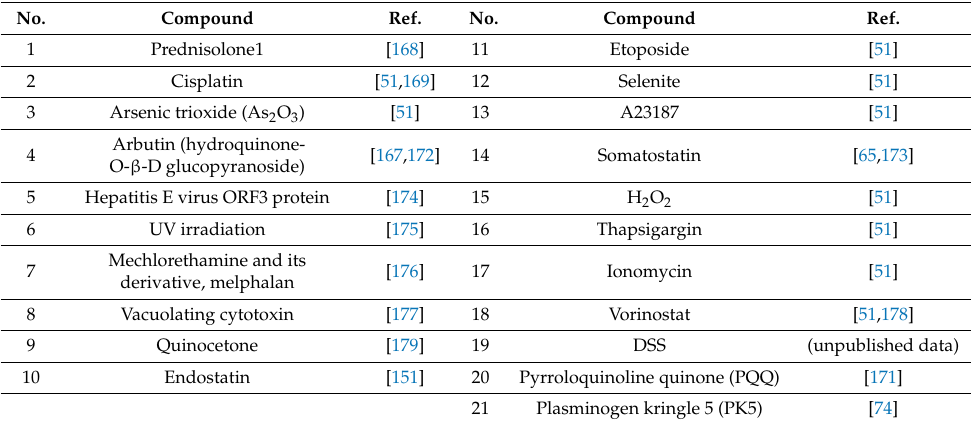
Table 1. Compounds and conditions inducing VDAC1 overexpression and cell